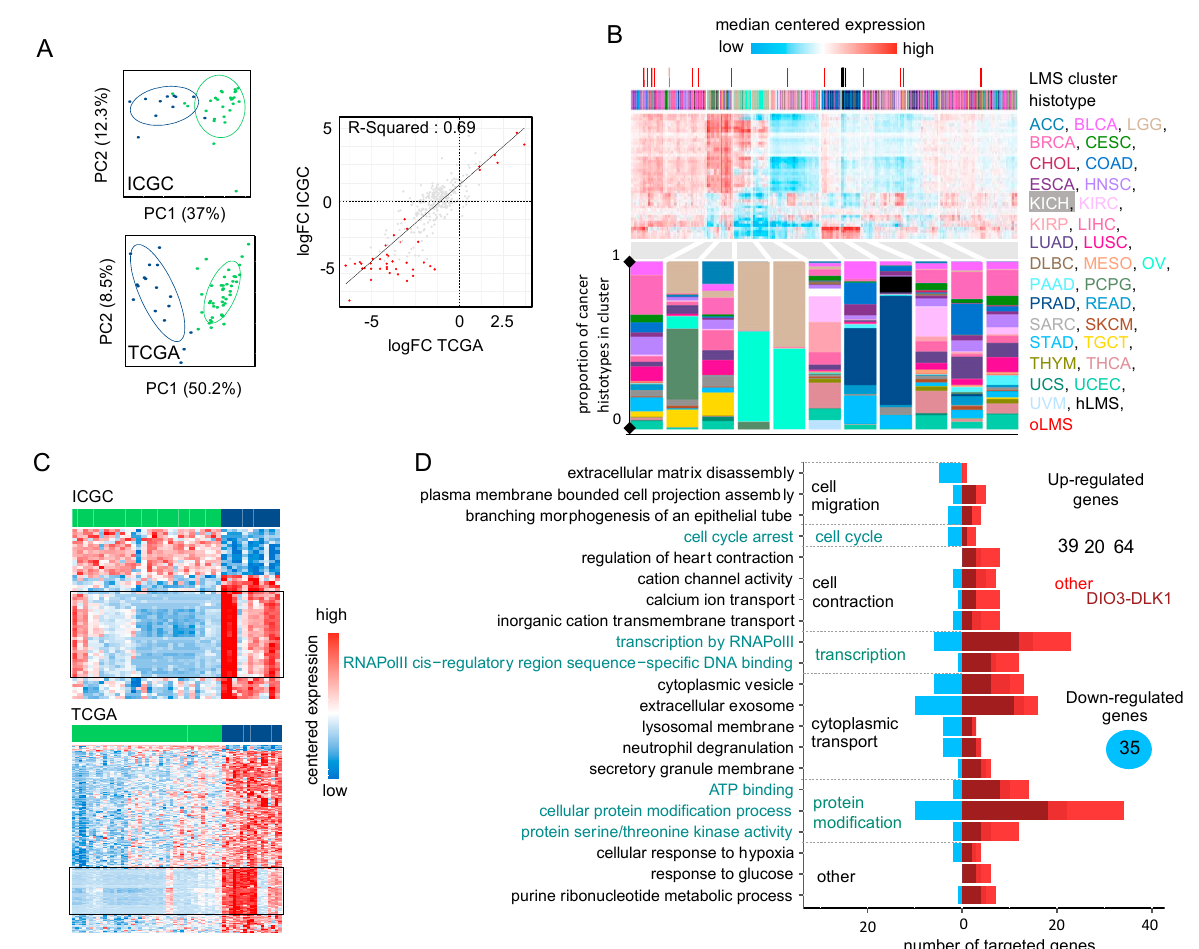
Figure 3. Analysis of miRNA expression ( A ). Left panel: PCA obtained from the expression of 484 mature miRNAs in 39 ICGC patients (top) and 475 mature miRNAs in 60 TCGA patients (bottom). Colors correspond to hLMS (green, ICGC: 28 patients, TCGA: 43 patients) and oLMS (blue, ICGC: 11 patients, TCGA: 17 patients). The first two principal components are shown with the percentage of variance they capture. Right panel: Scatterplot showing correlation between hLMS/oLMS Log Fold Change (LogFC) in ICGC ( y -axis) with TCGA ( x -axis). Each dot represents a mature miRNA (347 expressed in both cohorts), and red indicates 71 significant mature DE miRNAs in both cohorts. The line represents linear regression with interval confidence in shaded grey. ( B ). HCPC clustering on the 41 mature miRNAs differentially expressed in LMS subtypes across the 9564 PANCAN samples. Heatmap showing median-centered miRNA expression (low: blue to high: red). Column annotations represent the histotype of samples (bottom) and focus on LMS clusters (top) for which colors are specified at the bottom of the figure. Composition in the histotype of clusters is detailed in the bar plot below the heatmap. The y -axis corresponds to the proportion. ( C ). Heatmap showing differentially expressed miRNAs (rows) in ICGC (top, 55 miRNAs) and TCGA (bottom, 243 miRNAs). Column annotation corresponds to hLMS (green) and oLMS (blue). Expression values are median-centered (low: blue to high: red). Black rectangles highlight mature miRNAs from the DIO3-DLK1 miRNA cluster (ICGC: 26, TCGA: 63, 25 in common). ( D ). Functional terms mapped to 158 miRNA-targeted genes. The x -axis indicated a number of down-regulated (toward left in blue) and up-regulated (toward the right in dark red if targeted with only miRNAs from the DIO3-DLK1 cluster, medium red if targeted by both miRNAs from DIO3-DLK1 cluster and other miRNAs and light red if targeted by other miRNAs) genes annotated with the term ( y